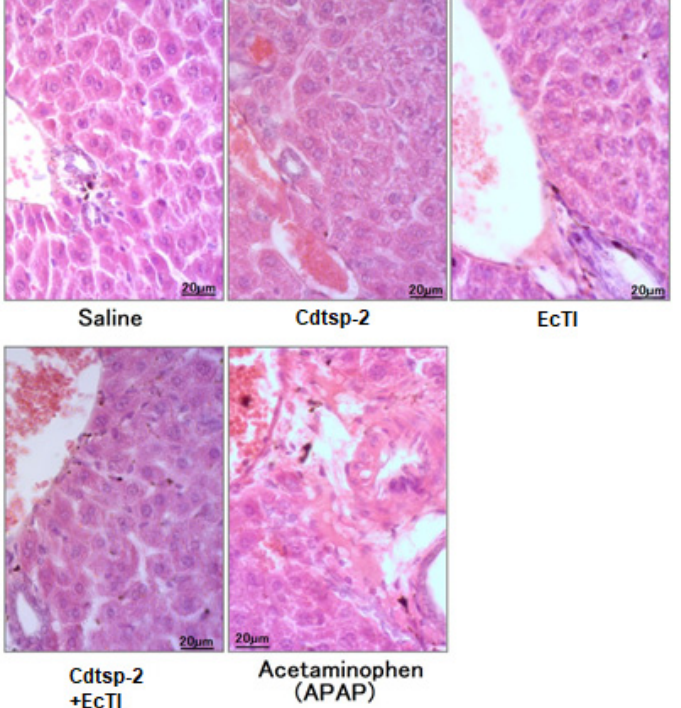
Figure 7. All samples present normal aspects, with neither infiltrated inflammatory or signals of necrosis. The pieces were processed according to the method described by Medeiros et al. for tests [19] and histopathological evaluations of the liver were made qualitatively with the aid of a light microscope in a blinded trial, based on the guidelines issued by the Society for Toxicologic Pathology [20] and the National Toxicology Program Health and Human Services [21].